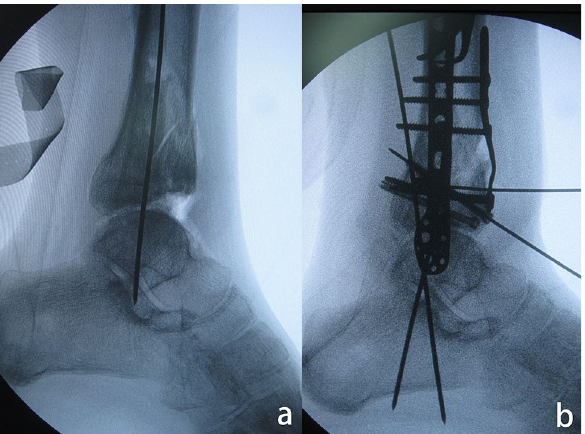
Figure 5. Anterior distal tibial plafond-plasty. ( a ) Impaction of the anterior distal tibial plafond was identified after anatomical reduction of the talus. ( b ) A congruent ankle joint was achieved. Screws and a buttress plate were utilized for